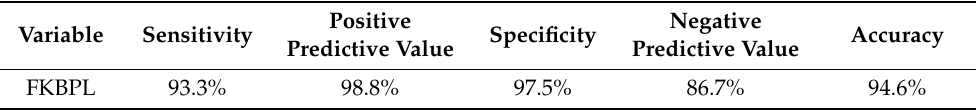
Table 4. Measures of diagnostic accuracy for FKBPL expression .